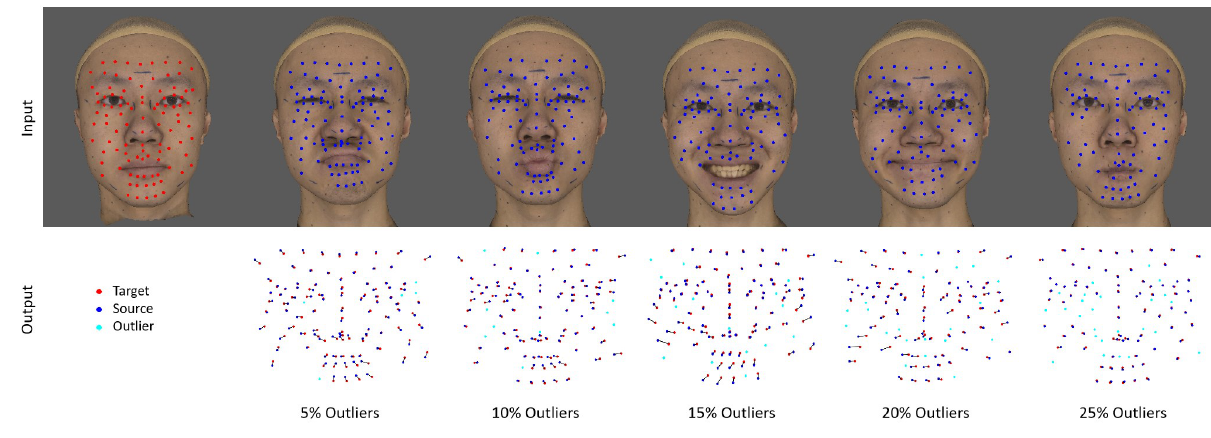
Figure 12. Matching cases for point sets with